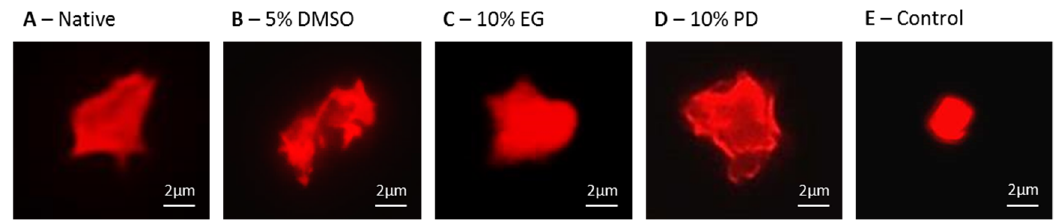
Figure 8. Functional PLTs activated with ADP and thrombin are capable to adhere to fibrinogen. Phalloidin-Texas Red staining binds to actin, allowing visualization of cytoskeleton. PLTs released from in vitro iPSC-derived MKs before ( A , E ) and after (( B )—5% DMSO; ( C )—10% EG; ( D )—10% PD) cryopreservation. ( E ) nonstimulated control.